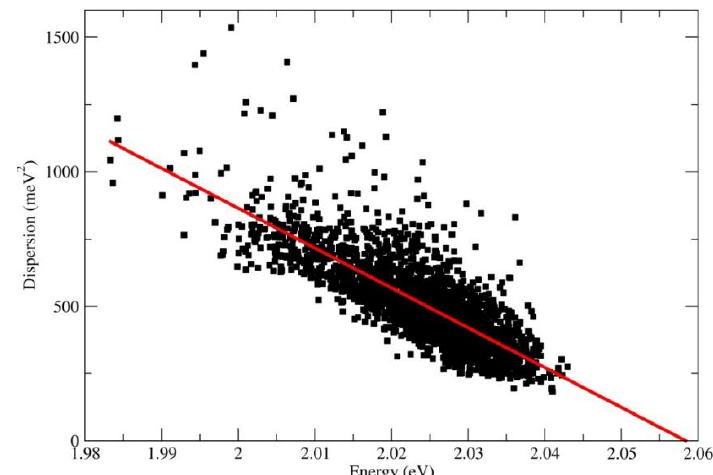
Fig. 1. The dependence of the dispersion on the peak wavelength. The points correspond to the experimentally obtained values at room temperature. The solid line indicates the theoretical dependence obtained in the proposed model based on the fluctuations of the electron-phonon